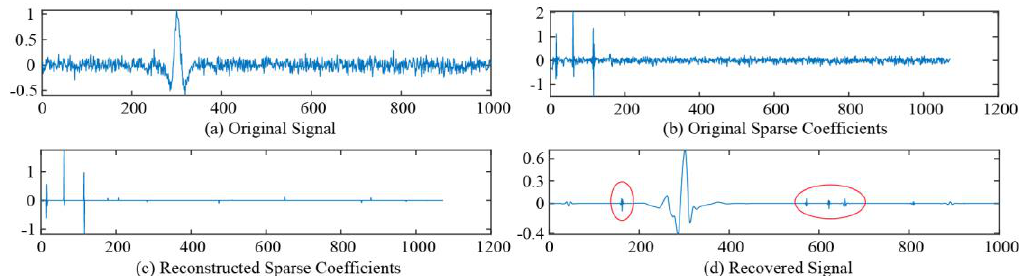
Figure 2. Ricker waveform reconstructed by compressed sensing. ( a ) Original signal, ( b ) original sparse coefficients, ( c ) reconstructed sparse coefficients, and ( d ) recovered signal.